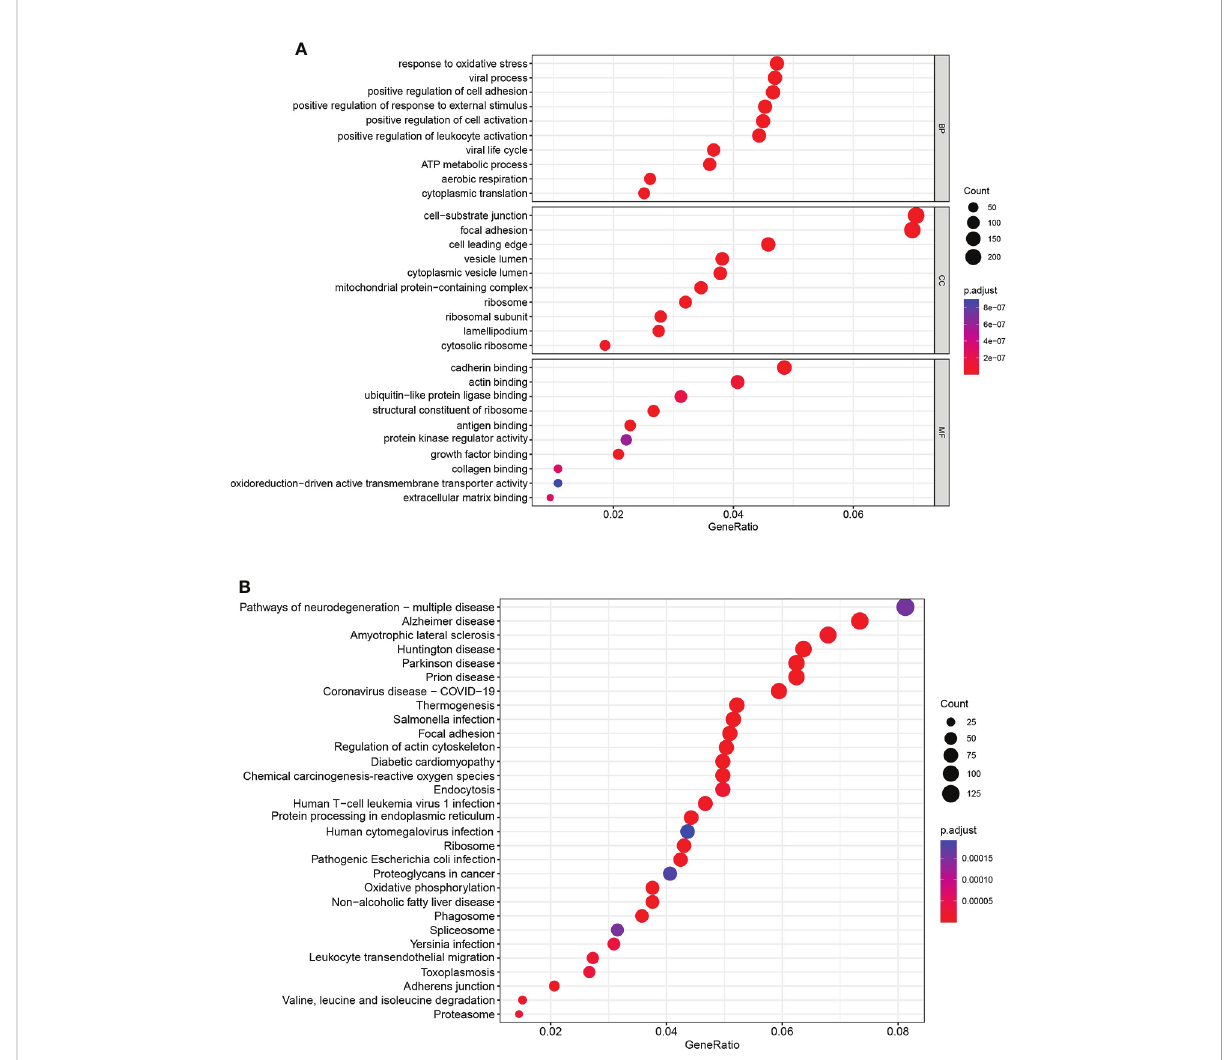
FIGURE 7 Functional enrichment analysis. (A) Gene Ontology analysis of DEGs revealed the enriched biological processes, cell components, and molecular functions. (B) Kyoto Encyclopedia of Genes and Genomes pathway analysis of DEGs revealed the enriched signaling